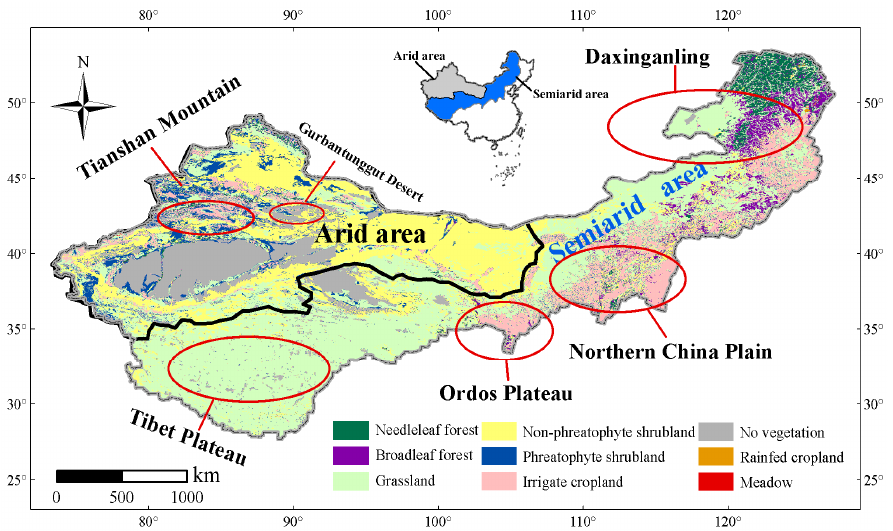
Figure 1. Study area and distribution of plant functional types (based on vegetation map of the People’s Republic of China (1:1,000,000)) [30].